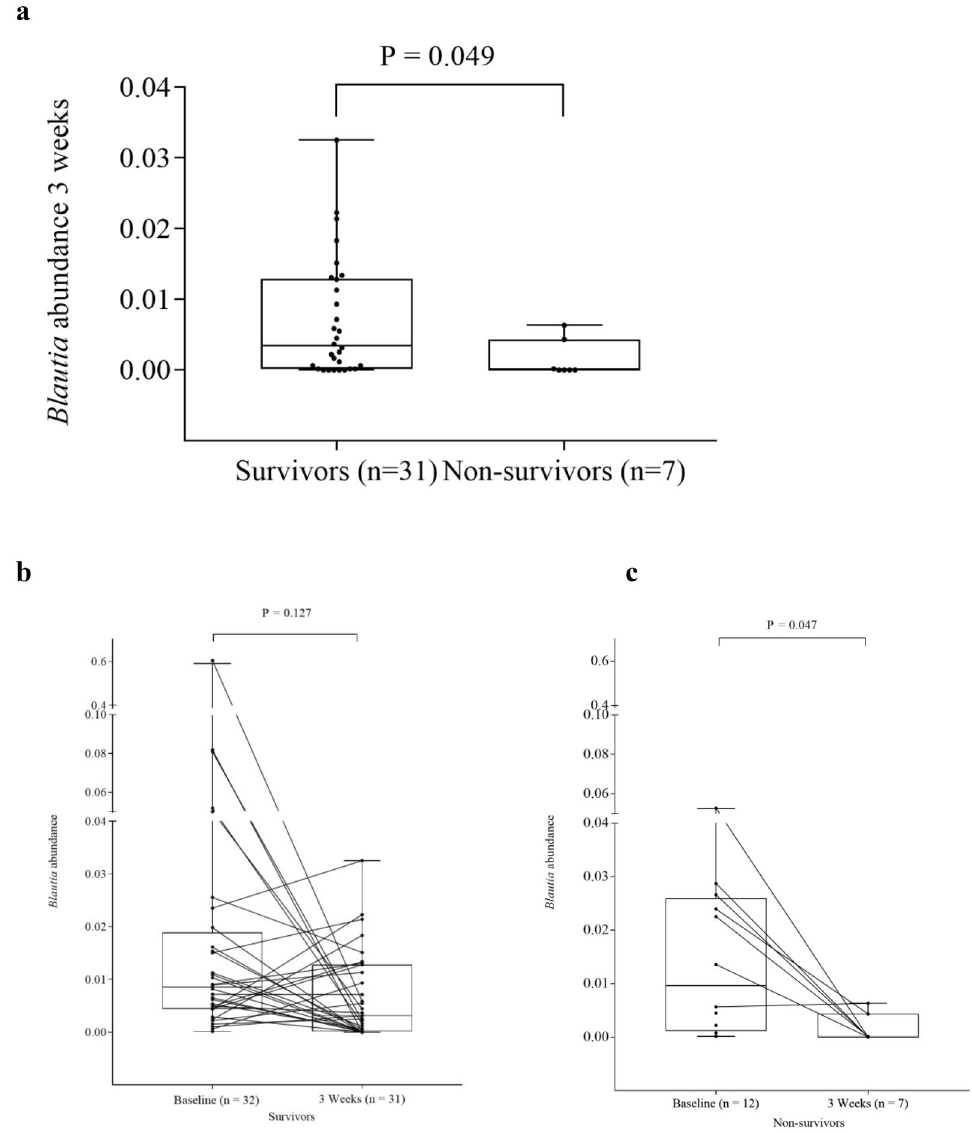
Figure 5. Blautia abundance and one-year survival. ( a ) Blautia abundance at 3 weeks and one-year survival, ( b ) and ( c ) Drop in Blautia abundance from baseline to 3 weeks and one-year survival. Data are Blautia abundance given as individual values (dots) and box plots (median and interquartile range) with minimum and maximum values. Lines connect individual data